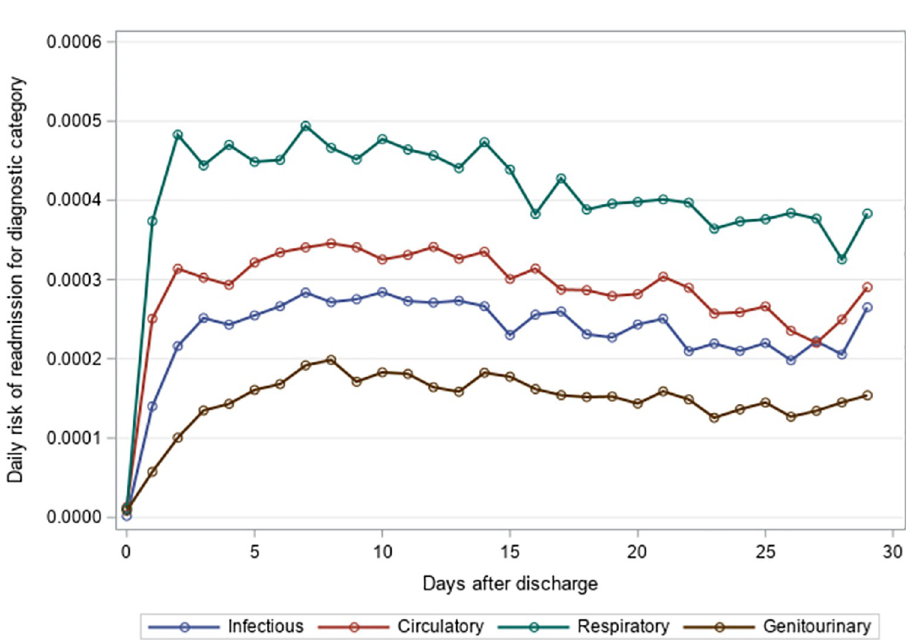
Fig 2. Daily risk of 30-day unplanned hospital readmission among older adults discharged to skilled nursing facilities following an index hospitalization for pneumonia, 2013–2014. Presents the daily risk of unplanned hospital readmission for four common causes of readmission (infectious, respiratory, circulatory, genitourinary). Each year started on the Sunday of Morbidity and Mortality Weekly Report week 27 and ended on the Saturday of Morbidity and Mortality Weekly Report week 26 of the following